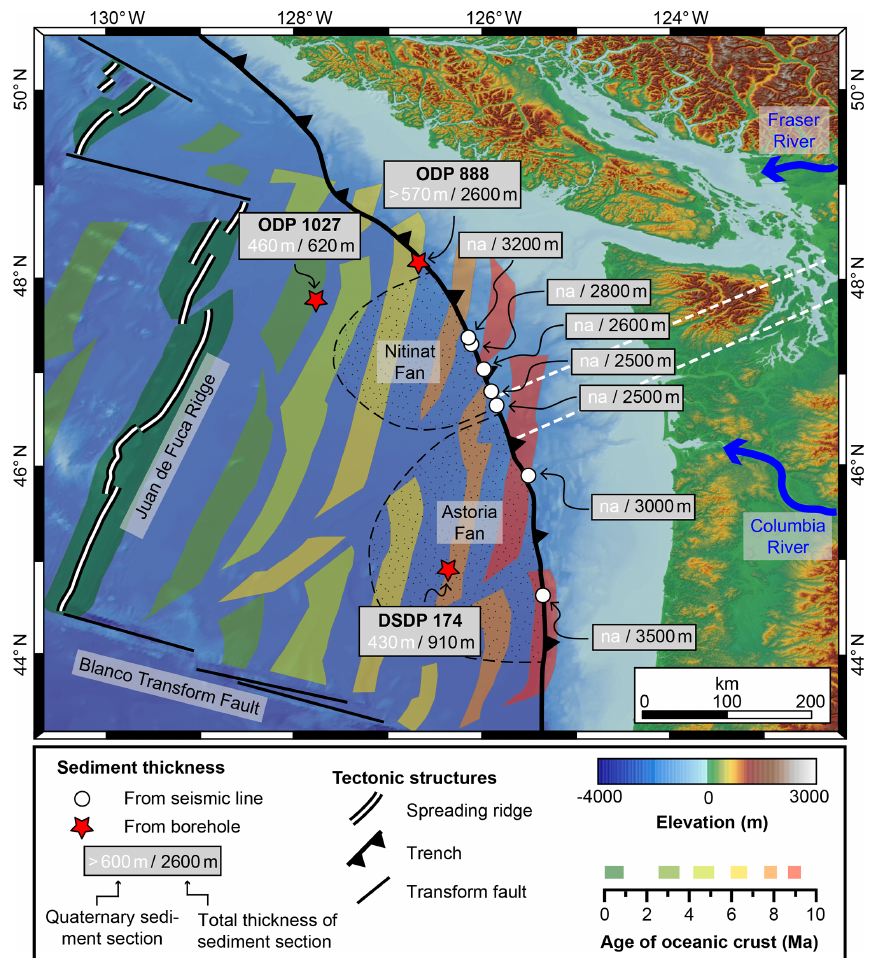
Figure 3. Map of the Cascadia Subduction Zone showing the age of the oceanic crust (Wilson, 1993) and sediment thickness, estimated from the sediment cores of ocean drilling programs (holes ODP 888, OPD 1027, and DSDP 174) and seismic studies (Adam et al., 2004; Booth-Rea et al., 2008; Han et al., 2016). The amount of Quaternary sediment material estimated from cores is also included (Kulm et al., 1973; Su et al., 2000; Westbrook et al., 1994); more information about the drill cores is provided in Table 1. The locations of two major submarine fans (Nitinat Fan and Astoria Fan) are indicated by the dotted pattern. The Fraser and Columbia rivers are the main modern sediment sources for the Nitinat and Astoria fans, respectively. White dashed lines indicate the position of cross sections presented in this study (see also Fig.